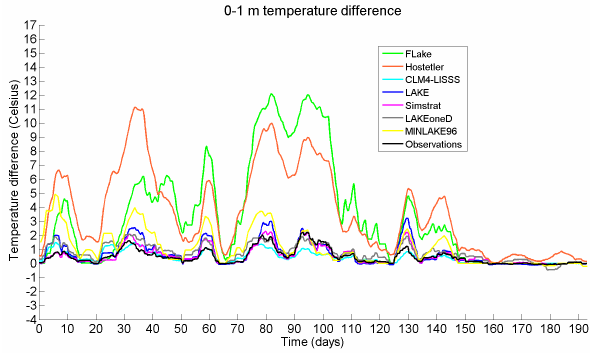
Fig. 4. Time series of 0–1m temperature difference by models and from observations (the depth in a point of observations is 1.2m). Both series are smoothed by moving average window equal to 5days. The time is counted from 00:00GMT, 1 May